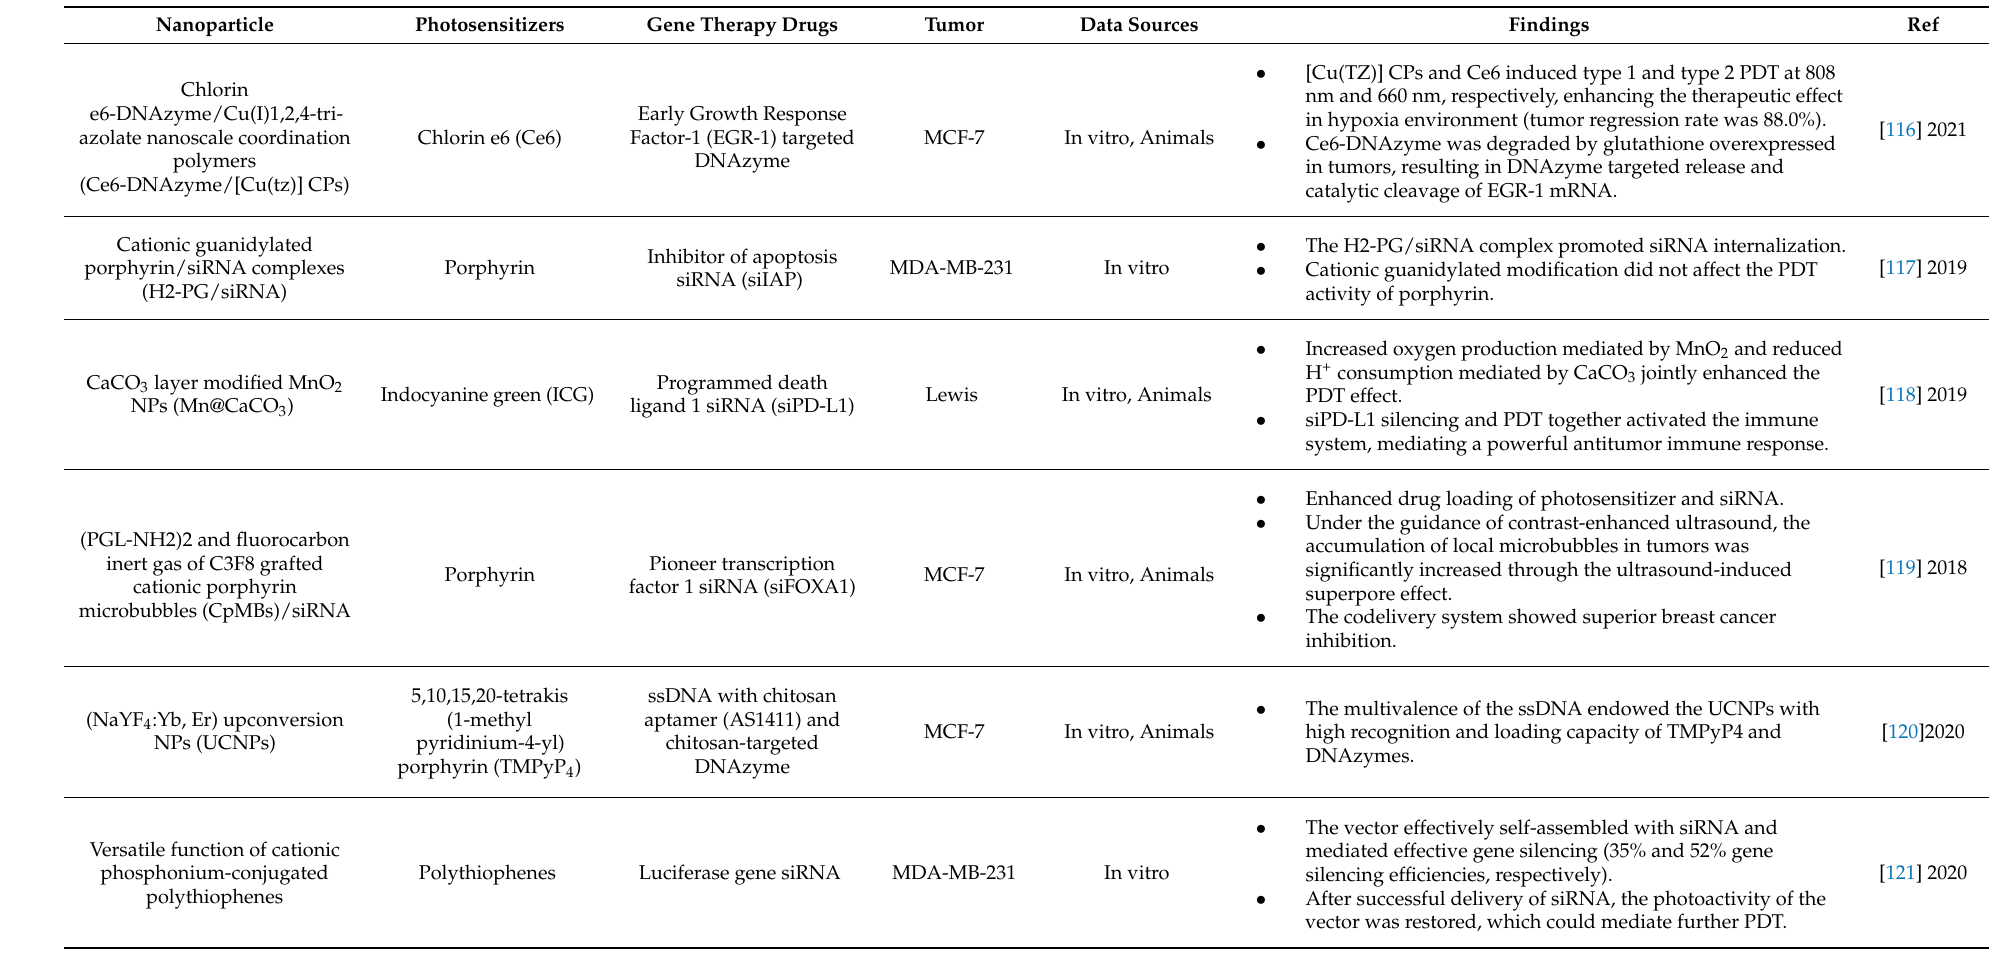
Table 2. Codelivery of photosensitizers and gene therapy drugs based on